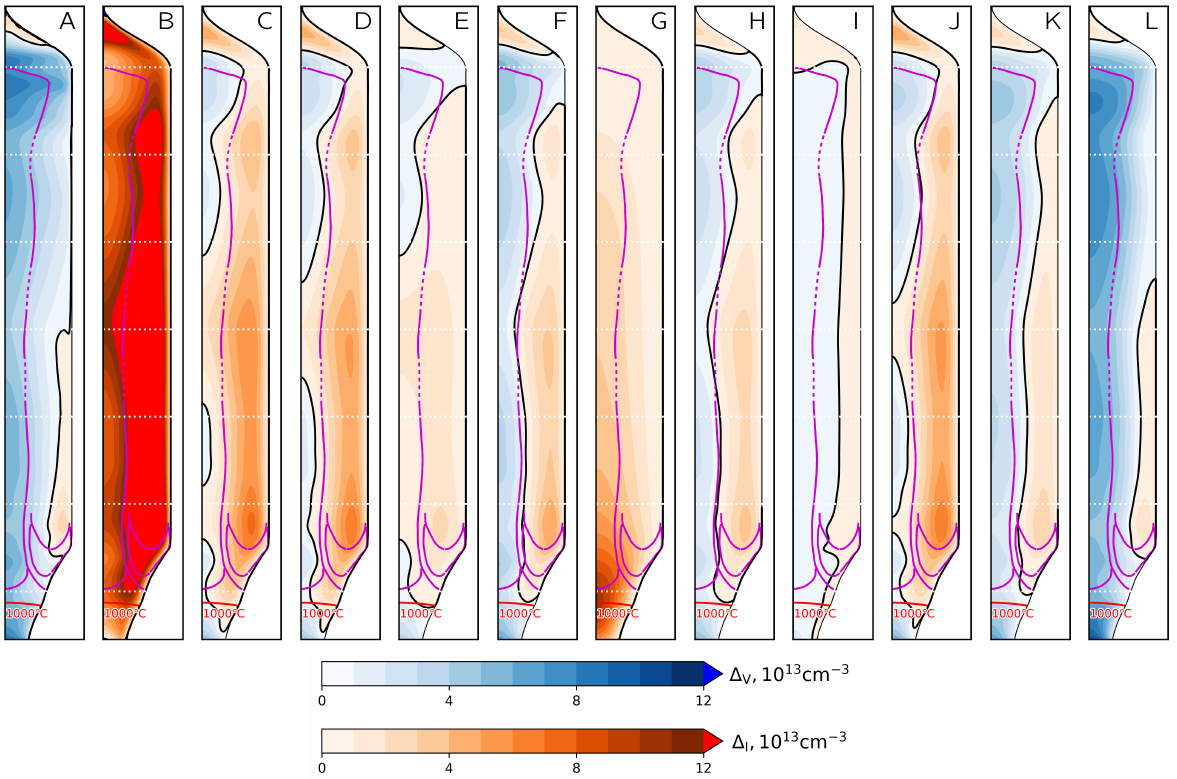
Figure 5. Comparison of PD distributions with experimental IVB (solid magenta curves—measurements, dashed lines— interpolation) for original PD parameter sets ( A – L ). Solid black curve— ∆ = 0, red curve— T = 1000°C below which PD are frozen-in, dotted white lines for length reference are plotted every 200mm starting from L =